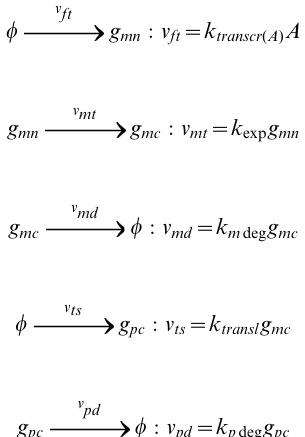
Figure 4. Behaviour of the model compared to experiment. A: total levels of nuclear FOXO in experiment (black) and simulation (grey) under conditions when Akt is inhibited (data from Biggs et al. [75] fig 1 D/K; CV1 cells treated with wortmannin, simulation with active Akt=10), low (data: Biggs et al. fig 1B/I; cells serum starved, simulation: Akt=1.75 6 10 3 ), high (data: Biggs et al. fig 1 A/H: cells growing asynchronously in serum, simulation: Akt=3 6 10 4 ), and hyperactive (data: Biggs et al. fig 1F/M: constitutively active PI3Kinase, simulation Akt=6 6 10 5 ). B: kinetics of transport of FOXO to cytoplasm. Experiment [75]: CV1 cells are serum-starved then growth factors are provided. Simulation: pre-equilibrated for 2 h with Akt=2 6 10 3 , then Akt increased to 2.5 6 10 4 at t=0. C: FOXO synthesis and degradation. Red: Expt: insulin 0.1 nM, MG132 10 m M; model: Akt=10 5 , Proteasomes=0. Black: Expt: serum-starved, model: Akt=100, Proteasomes=10 3 ), blue: Expt: insulin 0.1 nM; model: Akt=10 5 , Proteasomes=10 3 ). Experimental data taken from HepG2 cells (Matsuzaki et al 2003 [78]). D: Acetylation protects FOXO from degradation. Data points from b TC-3 cells (figure S5 in Kitamura et al [97]). Black: SIRT high (copy number 10 3 ), CBPP300 low (10); Red: SIRT moderate (200), CBPP300 active (10 3 ); Blue: SIRT low (10), CBPP300 high (10 3 ). Synthesis is inhibited (E2F1=0) and Akt active (10 5 ) in all simulations. E: degradation is accelerated by IKK activation: experimental data from MCF7 cells, from Hu et al [98] figure 5F, simulation: IKK=10 5 . F:Effectofacetylationontranscription: experiment:(fromMatsuzakietalFig1B[99])FOXO1- mediatedtranscriptioninHepG2cells of 3 6 IRS-MLP-luc by wild-type, 3KR (acetylation-resistant) and 3KA (acetylation-mimic); simulation: nuclear SOD2 mRNA with copy number of CBPP300=10 3 , copy number of SIRT1=10 3 (50:50),CBPP300=10, SIRT1=10 3 (deAc(etylated)), andCBP/P300=10 3 , SIRT1=10(Ac(etylated)); normalized so that transcription from 50:50=transcription fromWT. G: Upregulation oftranscription by AMPK: Experiment: Greer et al figure 7Aii, transcription of GADD45 with AMPK active and WT FOXO3 or 6A mutant (AMPK-phosphorylation-resistant); simulation: AMPK=10 5 or AMPK=100.